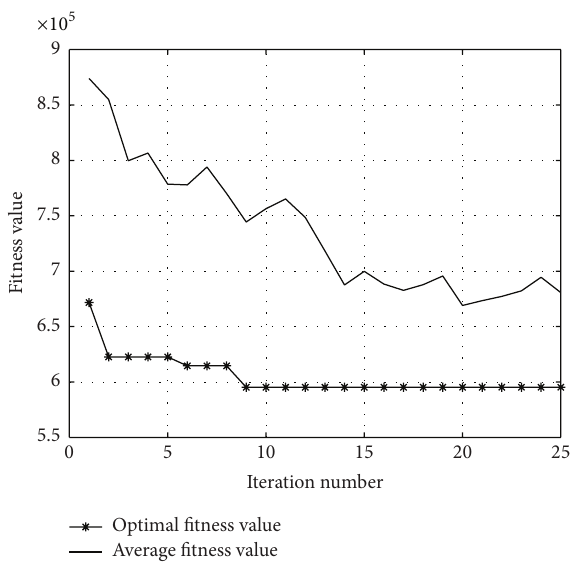
Figure 4: Particle swarm